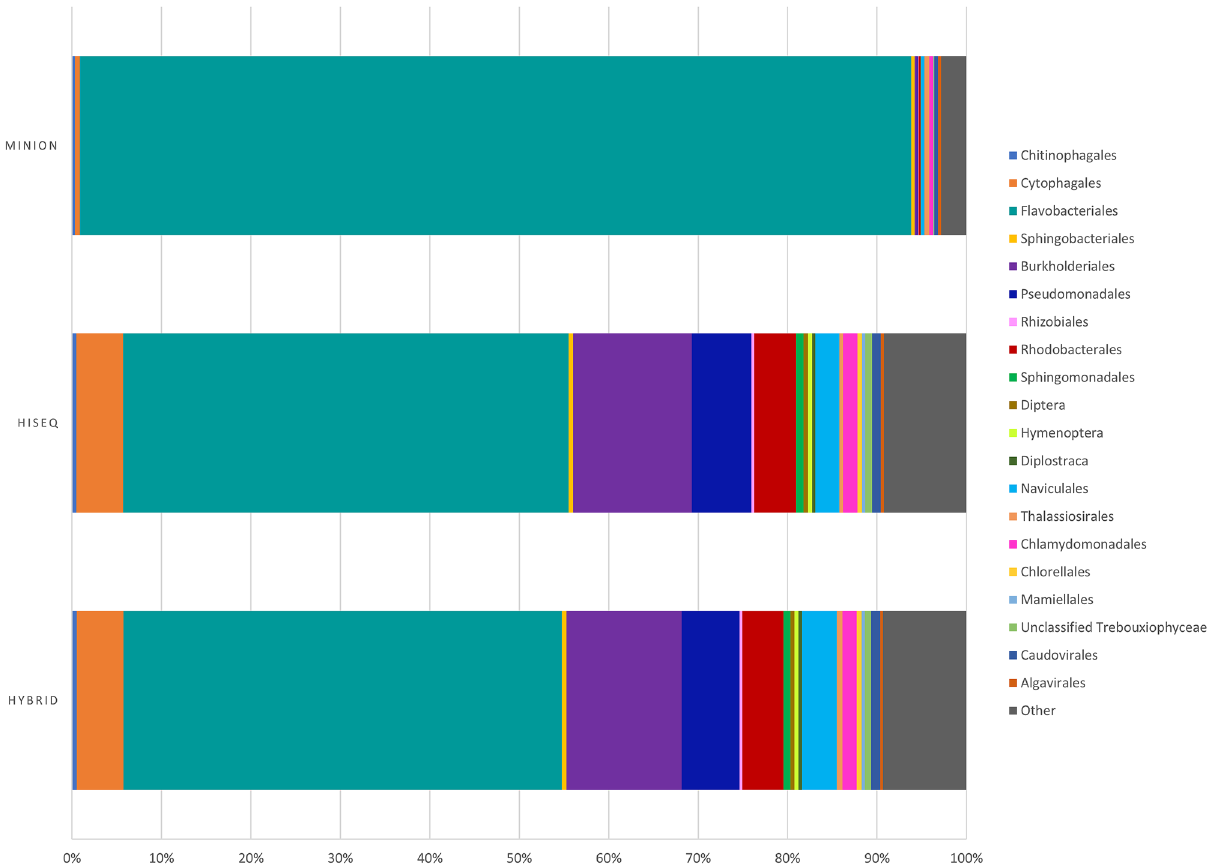
Figure 2. Community composition from metagenomes of the Allen Bay sea ice. The HiSeq-only metagenome, hybrid metagenome, and MinION-only metagenome are